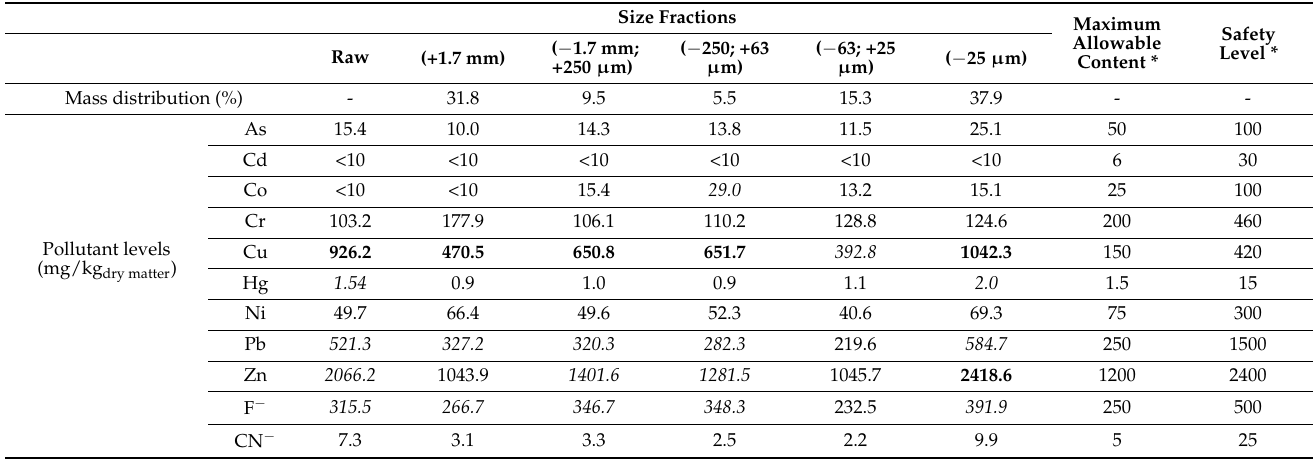
Table 5. Mass content distribution and inorganic pollutants level distribution inside NLS sediment compared to the thresholds specified in [42].